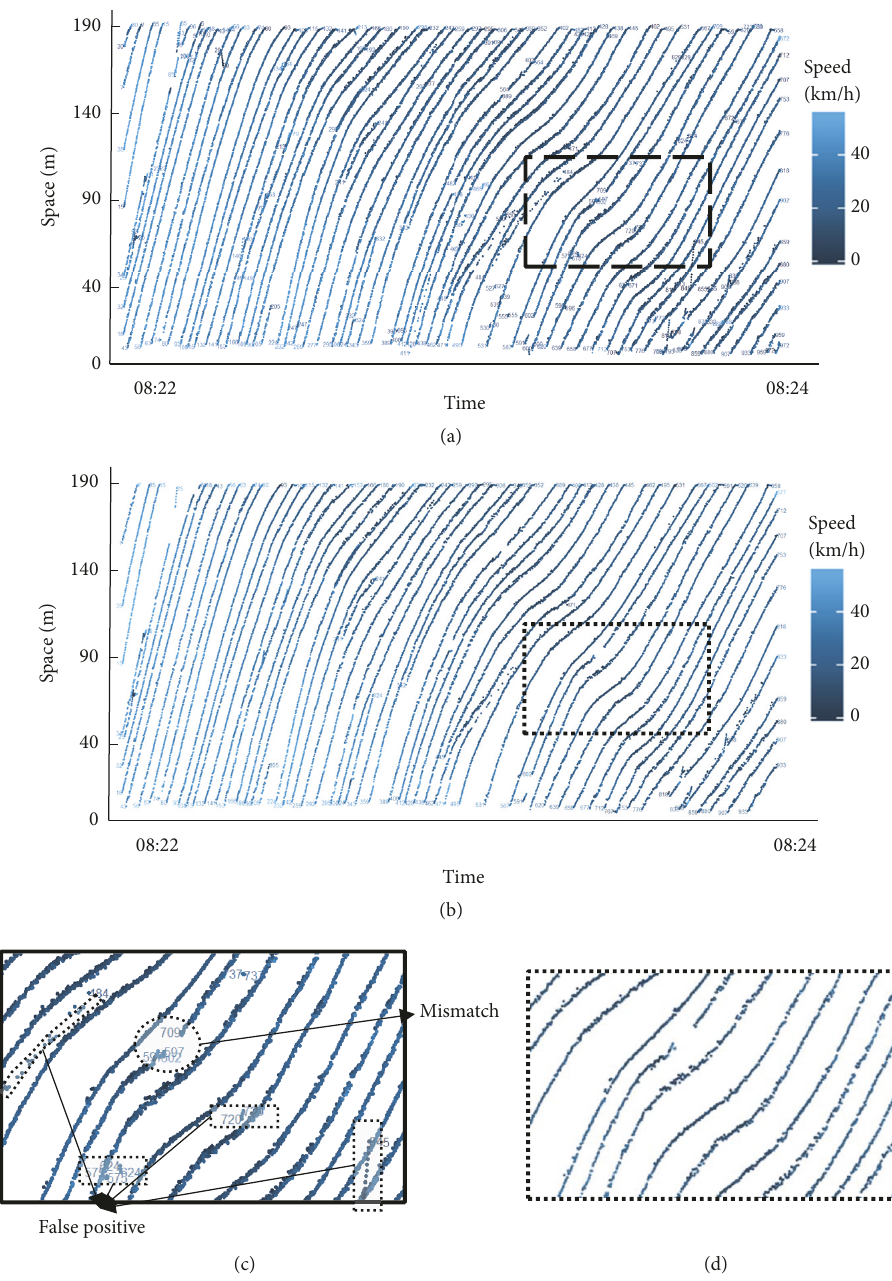
Figure7:Extractedvehicletrajectories(a)beforepostprocessingbydetectionwith94.5%F-measureand(b)afterpostprocessingbydetection with 94.5% F-measure.(c)Trackingerrors includingfalse positives and mismatchesin trajectorydata. (d) Results of postprocessing to remove tracking errors. The numbers in figures indicate the start and end points of each identified